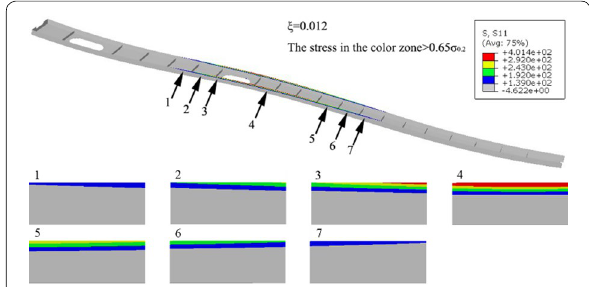
Figure 9 Different equivalent stress level regions of the long stringer (MPa)